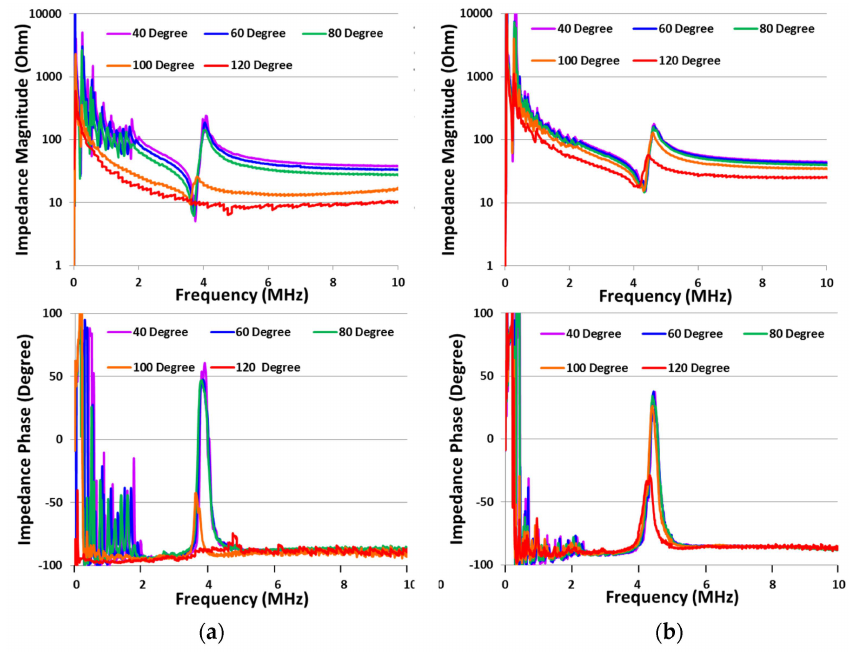
Figure 9. Impedance spectra of ( a ) PIN-PMN-PT and ( b ) Mn:PIN-PMN-PT when the electric field induced temperature was maintained as 40, 60, 80, 100 and 120 ˝ C.